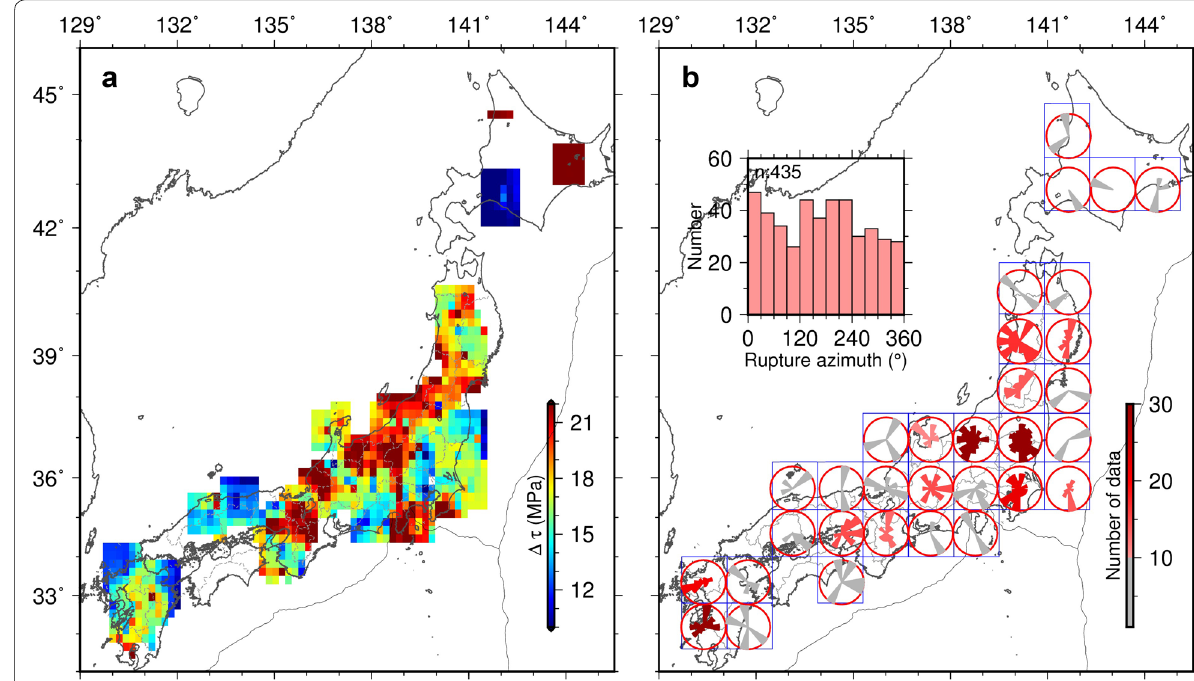
Fig. 4 Results of a spatial distribution of stress drop and b rupture directivity. In b, the rose diagrams show the relative frequency of rupture directions at the corresponding map